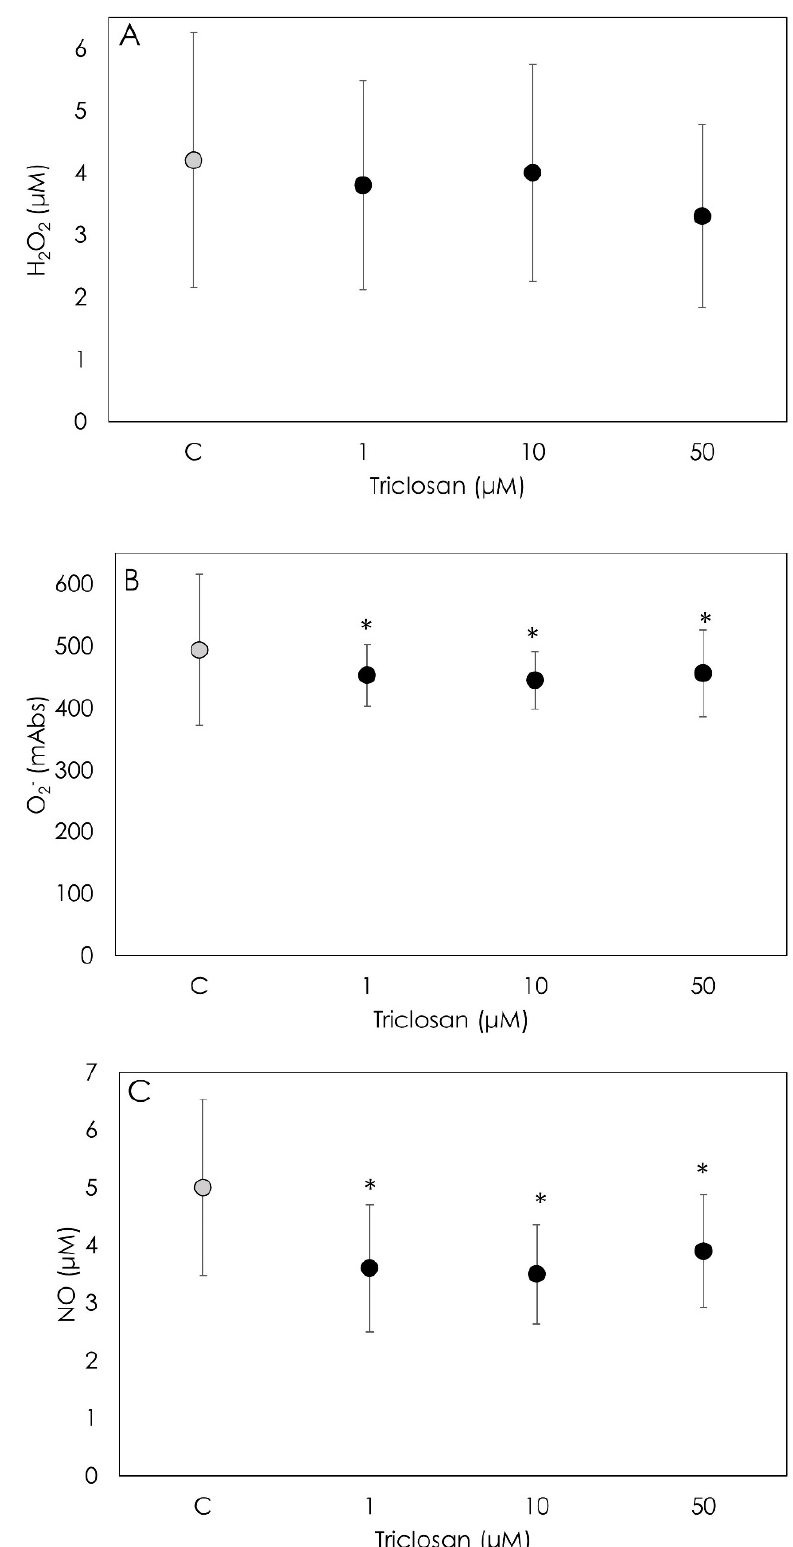
Figure 3. Results of hydrogen peroxide (H 2 O 2 ) ( A ), superoxide anion (O 2 − ) ( B ) and nitric oxide (NO) ( C ) generation using colorimetric assay on porcine granulosa cells treated for 48 h with Triclosan (1, 10 or 50 µ M). Data are expressed as milliAbs units ( B ) and as µ M ( A , C ) and represent the mean ± SD of six replicates/treatment repeated in five different experiments (n = 30). Asterisks on points indicate that data show significant differences ( p < 0.05).